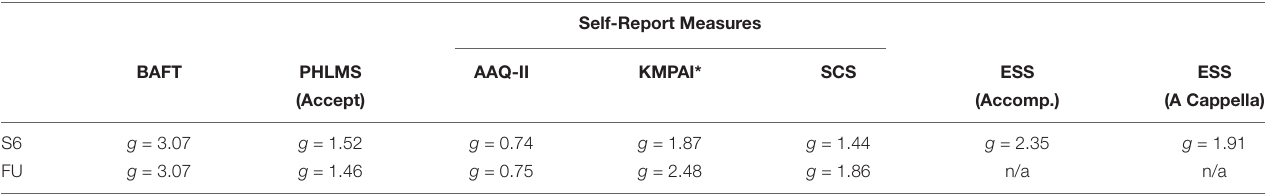
TABLE 2 | Effect sizes for changes in scores on self-report measures from Session 1 to Session 6 and to 3-month follow-up, using Hedges’ g